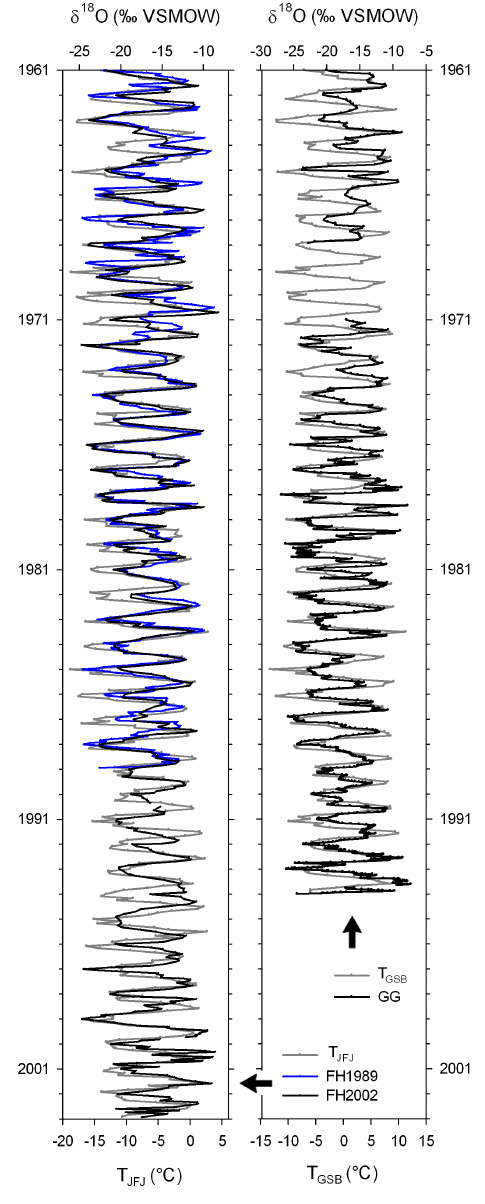
Figure 3. Left panel: δ 18 O raw data from the Fiescherhorn ice cores (FH2002, black, FH1989, blue), together with the monthly temper- ature at the Jungfraujoch station (grey). Right panel: δ 18 O raw data from the Grenzgletscher ice core (black), together with the monthly temperature at the Grand Saint Bernard